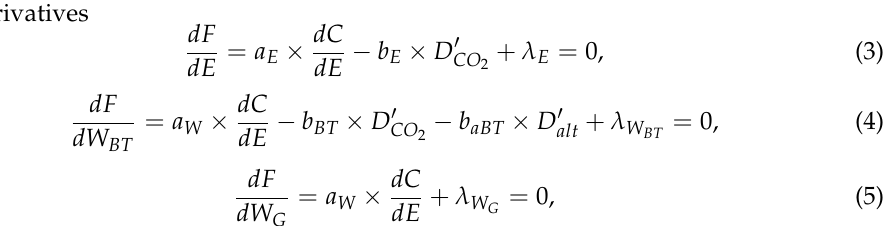
Figure 4. A two-stage model for deriving the optimal investment decision. Using Lagrange optimization, the optimal solution on Stage 2 is described by